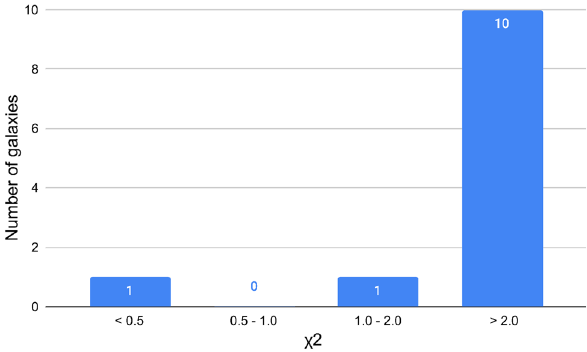
Fig. 13 The distribution of the χ 2 values for a set of 12 galaxies for R = 16 kpc, ϒ d = 0 . 5, and ϒ b = 0